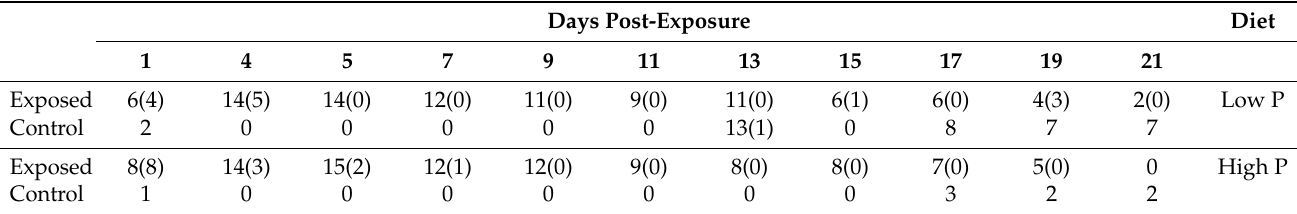
Table 4. Number of faeces screened from exposed and control bumblebees in each diet at different days post-exposure. Number of faeces samples showing spores is shown in